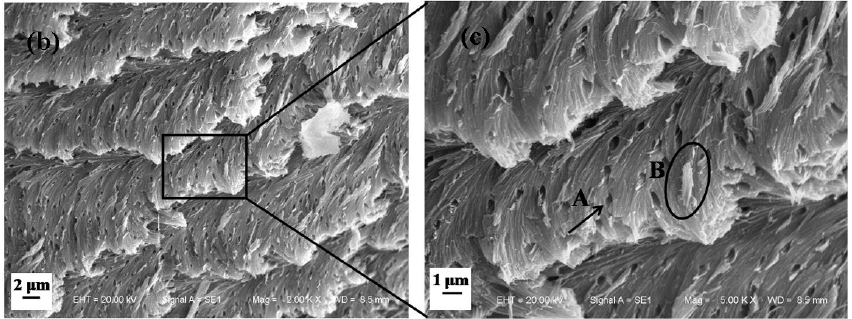
Figure 8. Microstructure of longitudinal section of dactylopodite: ( a ) Layered structure in exocuticle, ( b , c ) pore canal and pore canal tubule.